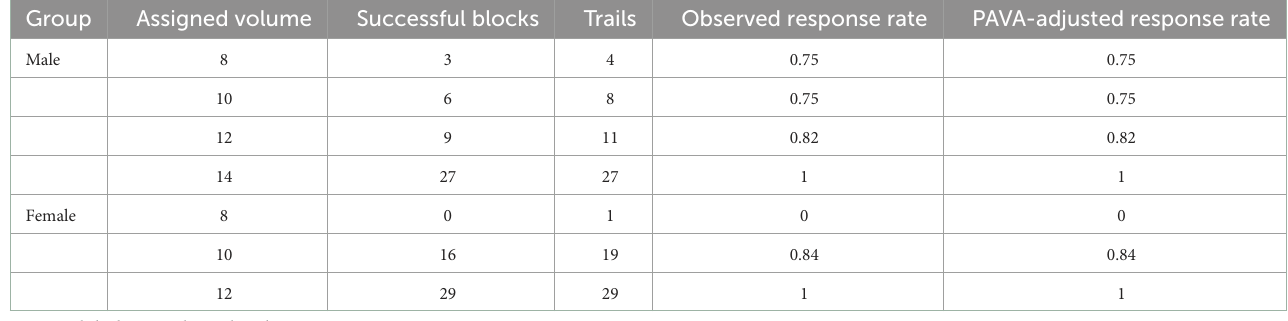
TABLE 2 Observed and pooled-adjacent violators algorithm-adjusted response rates. Group